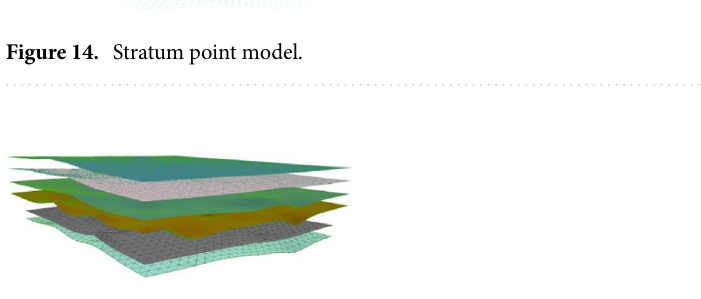
Figure 15. Stratigraphic interface model.